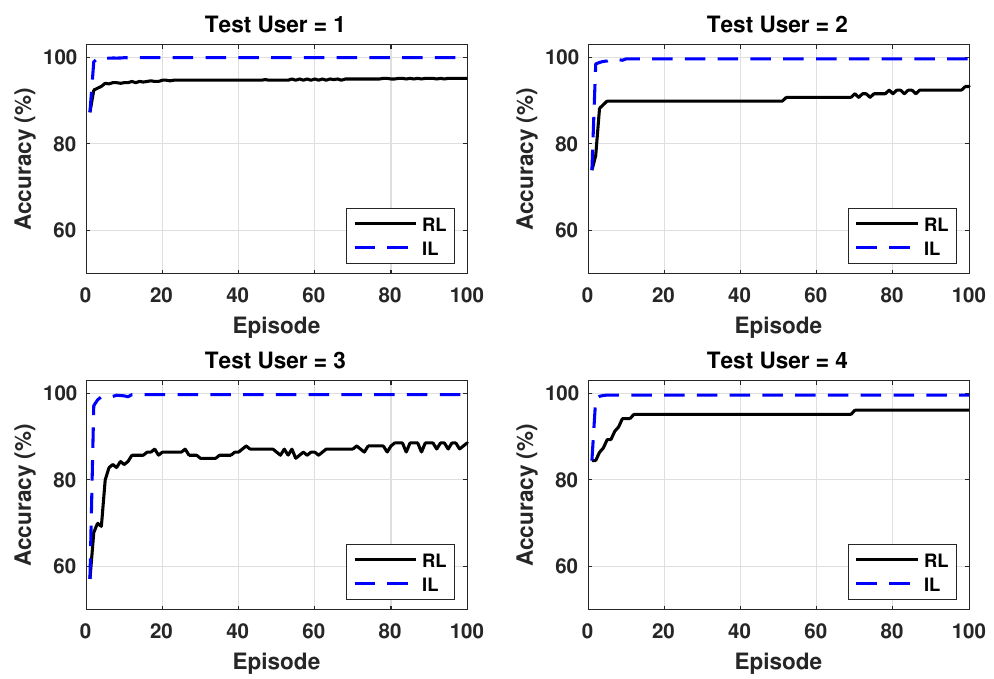
Figure 8. Comparison of reinforcement learning and incremental